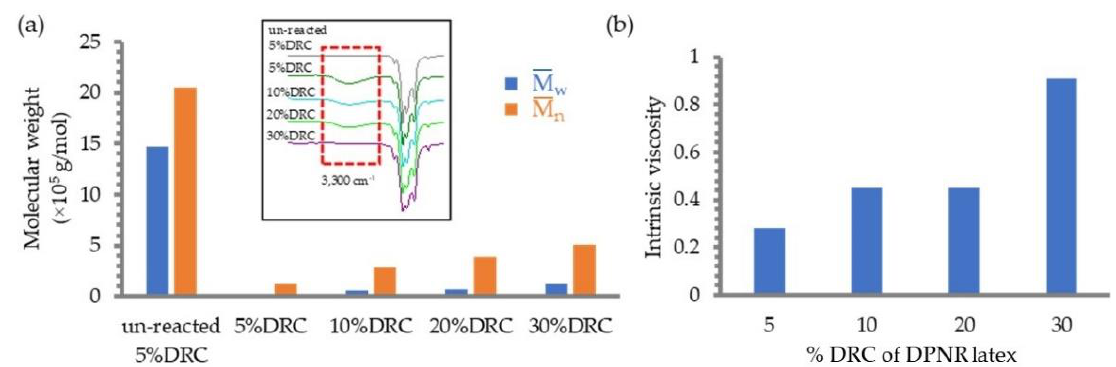
Figure 6. Effect of the latex concentrations on ( a ) the MW and the change of FT-IR spectra, and ( b ) intrinsic viscosity of DPNR after the reaction in the presence of H 2 O 2 and TiO 2 film irradiated with UV light for 5 h.